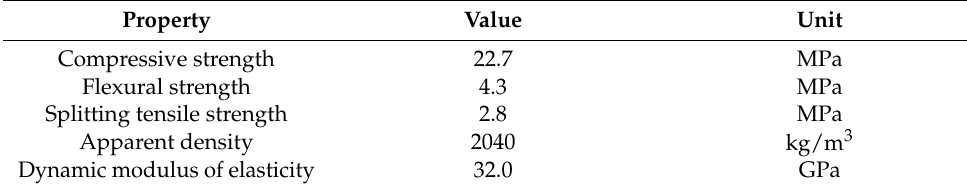
Table 2. Mechanical characteristics of hardened mortar. Property Value Unit Compressive strength 22.7 MPa Flexural strength 4.3 Splitting tensile strength 2.8 Apparent density